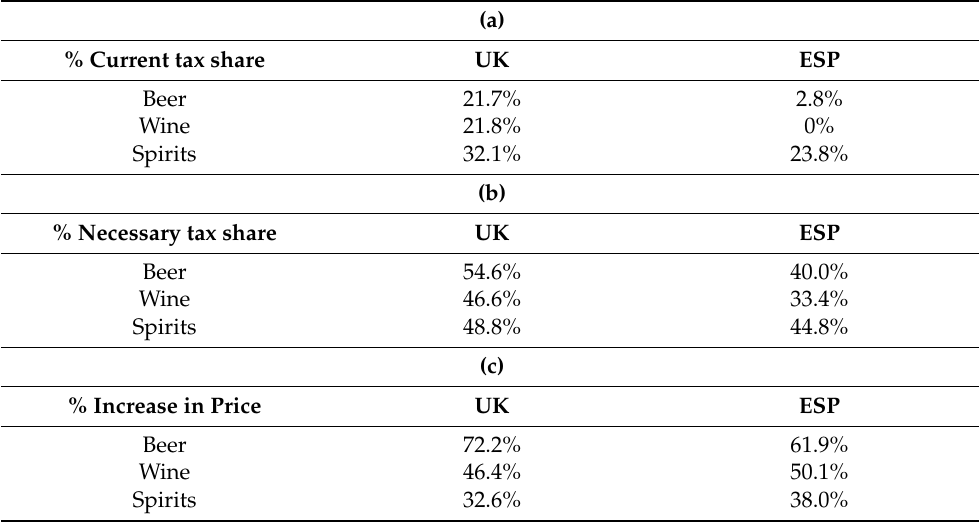
Table 2. Current tax share ( a ) and tax share necessary to achieve the effect of a 10% reduction in alcoholic strength, along with ( b ) resulting increase in price ( c